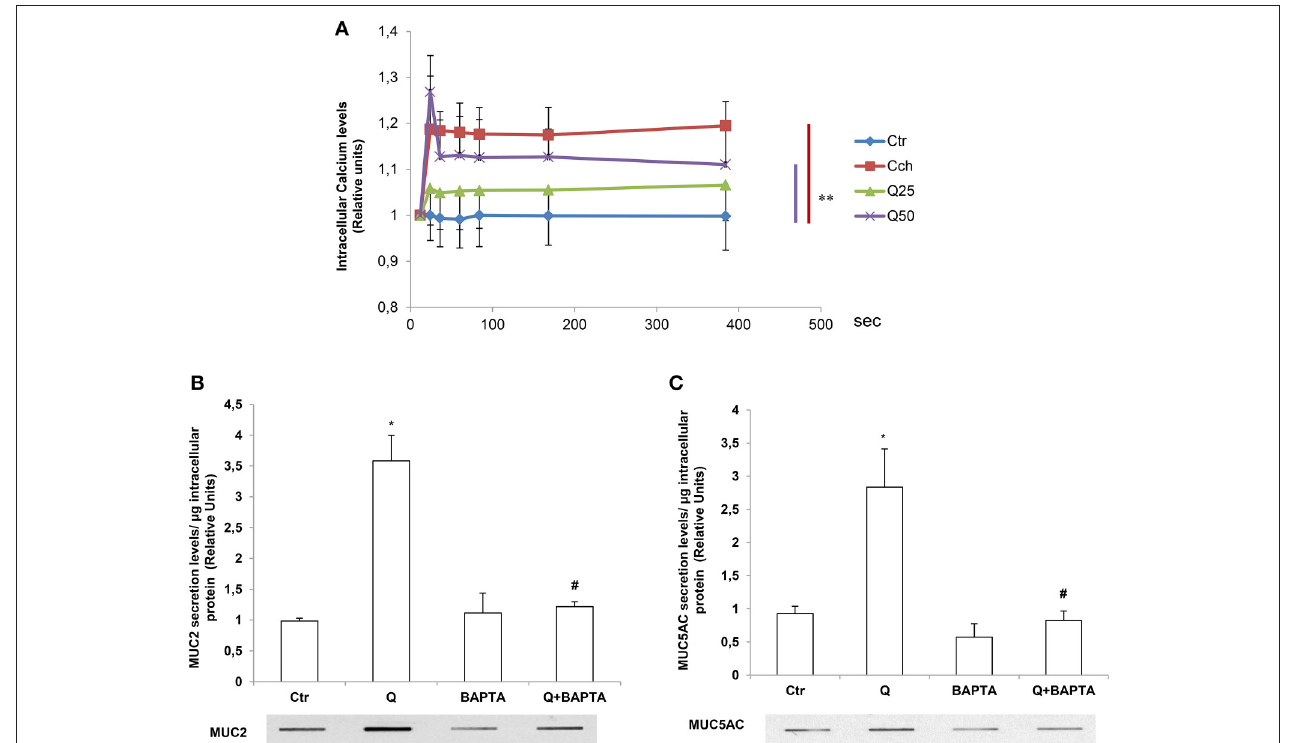
FIGURE 4 | The induction of MUC2 and MUC5AC secretion by quercetin is Ca 2 + - dependent. (A) Fluorimetric analysis of intracellular Ca 2 + levels in LS174T cells stimulated with 25 (25Q) and 50 (50Q) µ M quercetin or 1mM carbachol (Cch). Each point represents the mean ± SE ( n = 3) of three independent experimental sessions. ** p < 0.01 vs. Ctr. (B,C) Slot-Blot analysis of incubation medium of LS174T cells grown for 24h in MEM without serum and stimulated with 50 µ M quercetin in the absence or presence of the Ca 2 + chelator BAPTA-AM. The histogram shows the mean ± SE ( n = 3) of the MUC2 (B) and MUC5AC (C) proteins, obtained by densitometric analysis of three independent experiments and normalized for the respective cell protein concentrations. * p < 0.05 vs. Ctr, # p < 0.05 vs. Q.